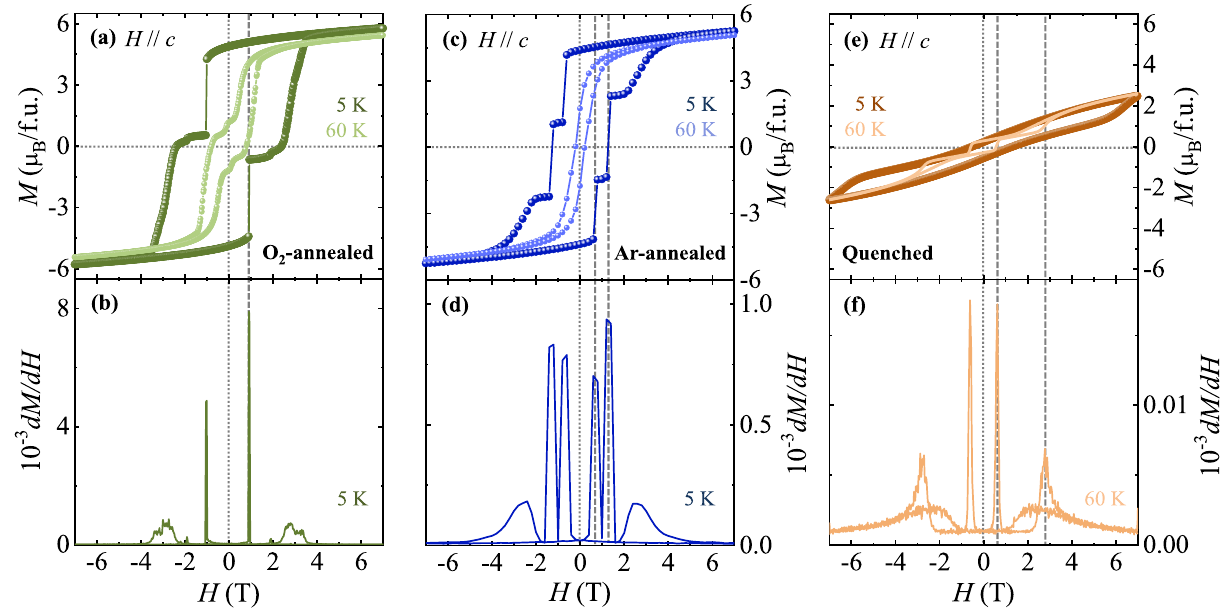
Figure 4. Isothermal magnetization for the annealed crystals. Isothermal magnetization for the ( a ) O 2 - annealed crystal, ( c ) Ar-annealed crystal, and ( e ) quenched crystal, along the c axis, up to 7 T, at T = 5 and 60 K, and the magnetic-field derivative of magnetization for the ( b ) O 2 -annealed crystal at 5 K, ( d ) Ar-annealed crystal 5 K, and ( f ) quenched crystal 60